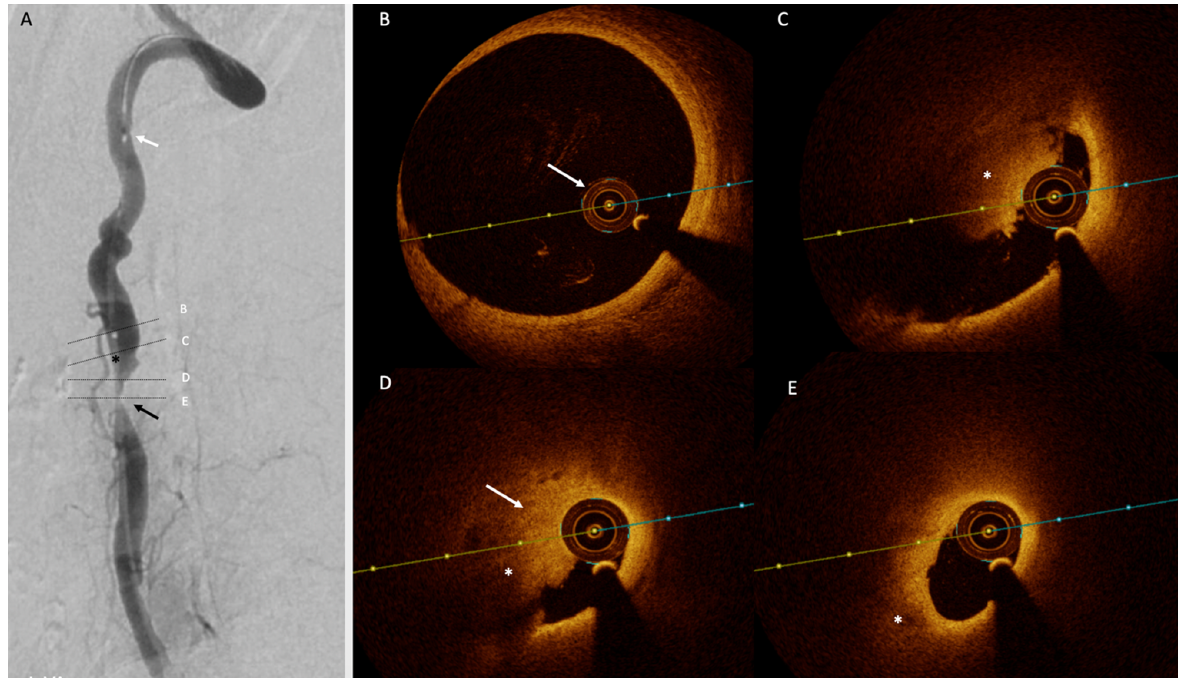
Figure 2. Pre-stenting angiography and OCT images. ( A ) Digital subtraction angiography image of the left V2 segment prior to stenting. Intraluminal thrombus was seen as an irregular intraluminal filling defect (black arrow), and severe stenosis of the underlying vessel was deemed suitable for stenting. An intraluminal filling defect above the stenosis was illustrated by OCT layer (dash). Cross-sectional OCT images during standard pullback with the OCT catheter tip location indicated as a white arrow showed ( B ) normal lumen proximally with no thrombus and ( C – D ) red thrombus distally manifested as an irregular hyper-reflective region projecting into the lumen (*), with posterior shadowing. ( E ) Eccentric stenosis relating to the atherosclerotic plaque containing fibro-lipid components appears as a homogenous, hypo-reflective region (*).